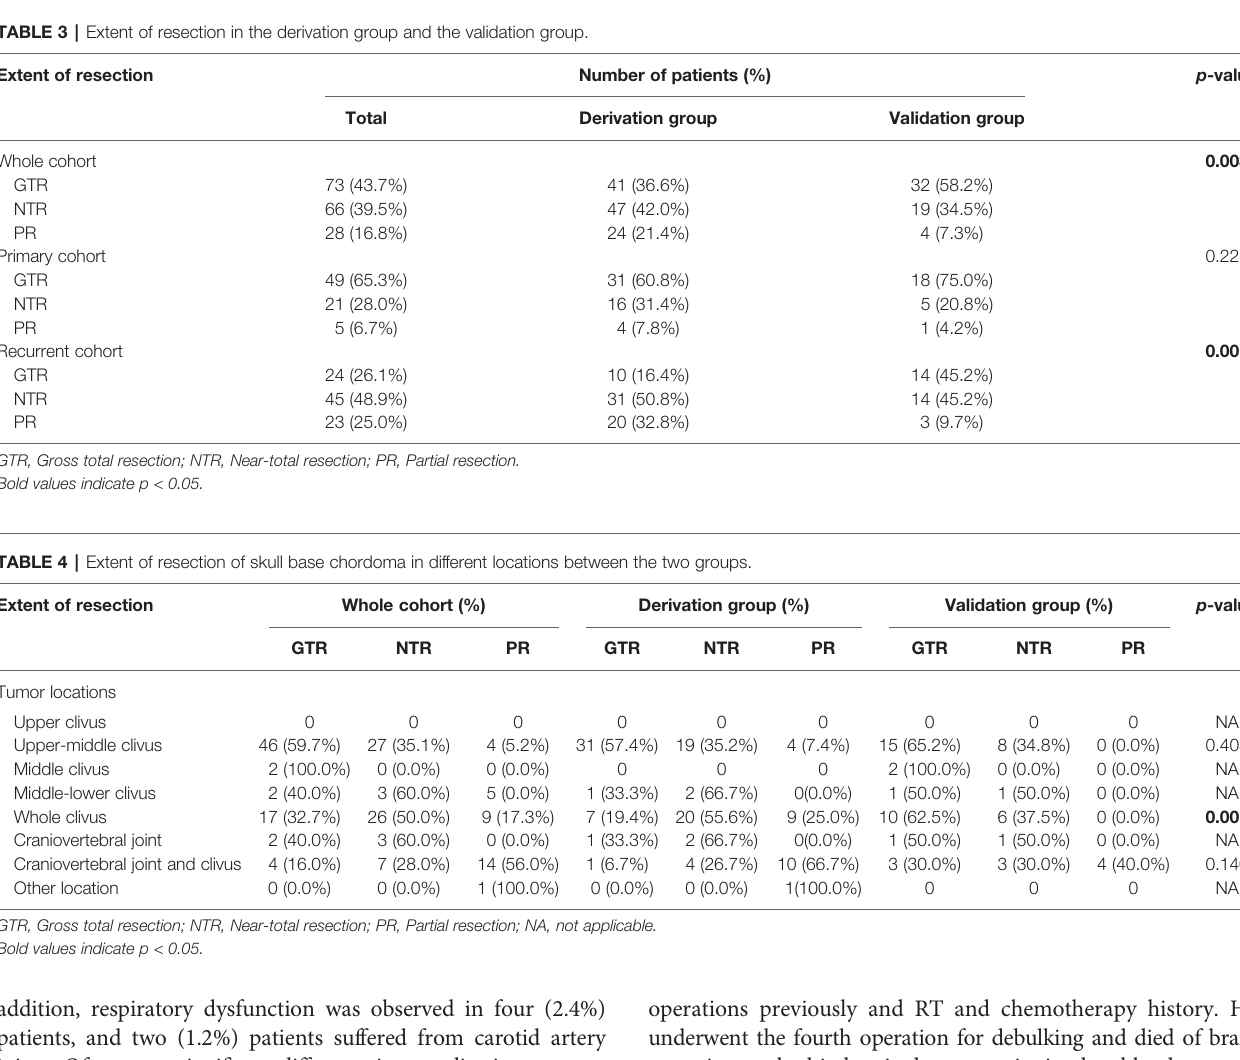
addition, respiratory dysfunction was observed in four (2.4%) patients, and two (1.2%) patients suffered from carotid artery injury. Of note, no signi fi cant difference in complication rate was observed between the discovery and validation groups (13.4% versus 12.7%, p = 0.905) ( Table 5 ).